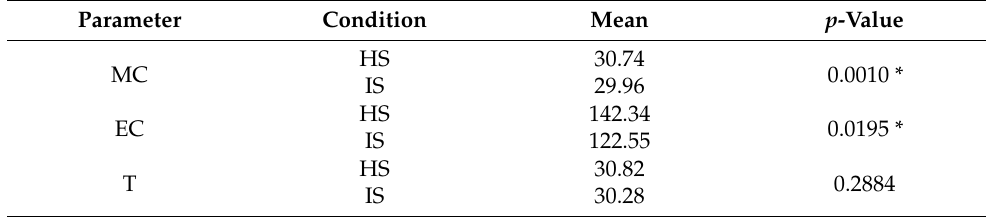
Table 1. Mean and p -value of monthly